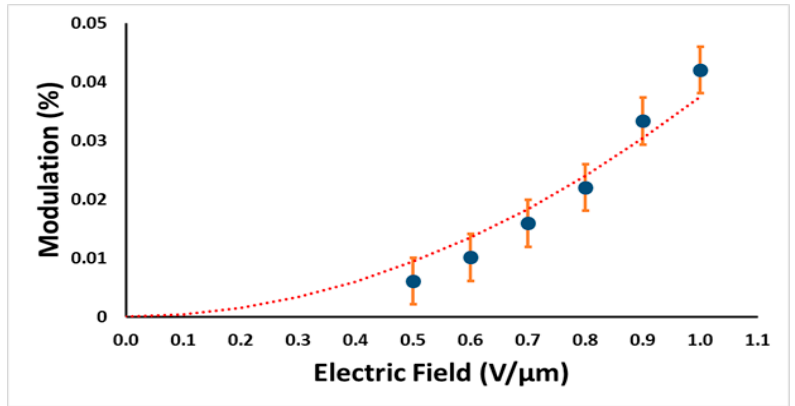
Figure 4. Electroabsorption modulation in a nonconjugated conductive polymer (iodine-doped polyisoprene) for different applied electric fields. Film thickness ~1 µm.